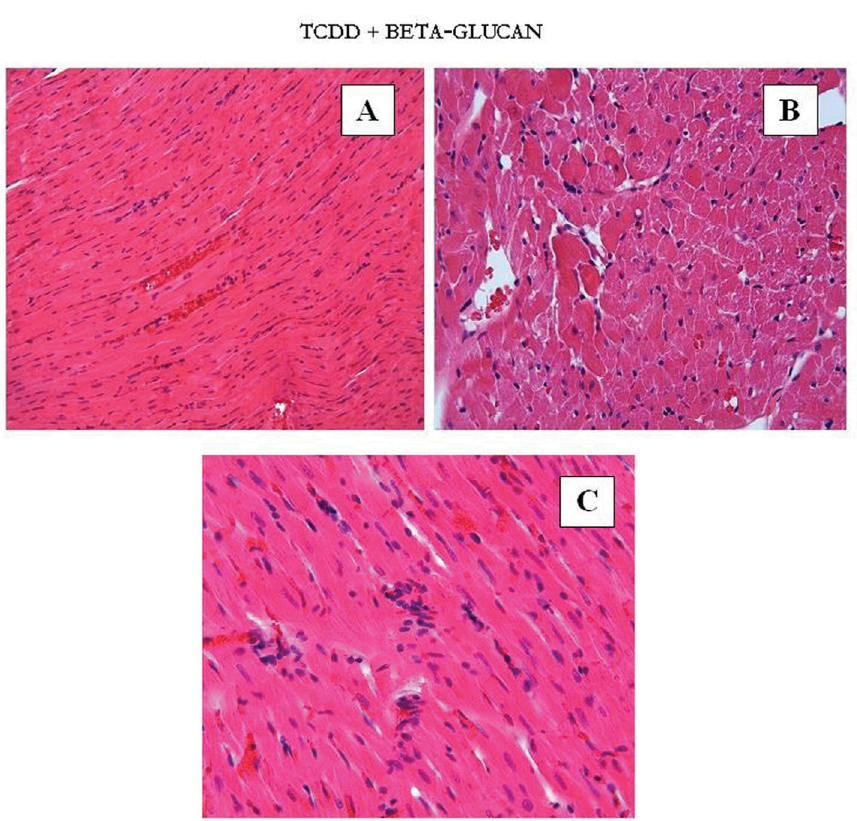
FIGURE 3 - TCDD + beta-glucan group . Degenerative changes were decreased in TCDD+beta-glucan group compared with TCDD group. A: H-E; X20, B, C: H-E;